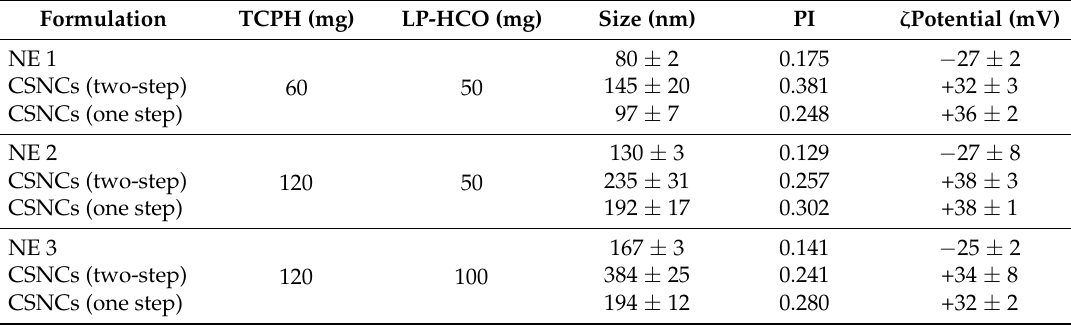
Table 1. Composition and physicochemical characteristics of nanoemulsions (NE) and chitosan nanocapsules (CSNCs). TCPH: vitamin E, LP-HCO: Lipocol HCO-40, and PI: polydispersity index. The amount of EmFas-30 remained constant (20 µ